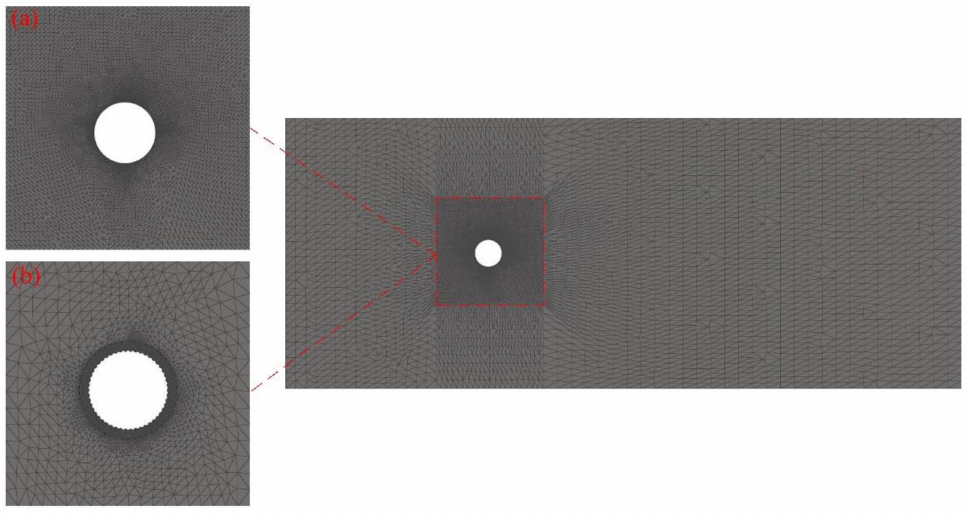
Figure 6. Elements of the meshed computational fluid domain: ( a ) O–tower; ( b )